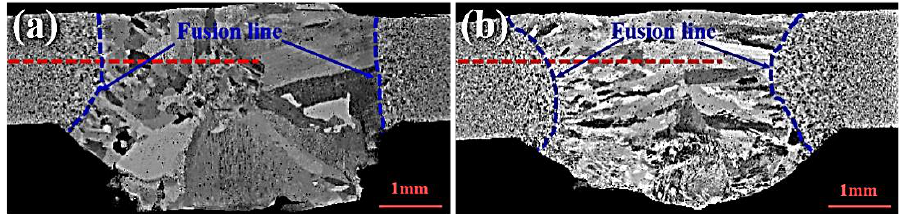
Figure 1. Shape of the gas tungsten arc (GTA) weld cross-sections using various filler metals: ( a ) stainless steel (STS) 308L and ( b ) high-entropy alloys (HEA). Red- and blue-dotted lines indicate the location of the quantitative electron probe microanalysis (EPMA) and fusion lines, respectively.